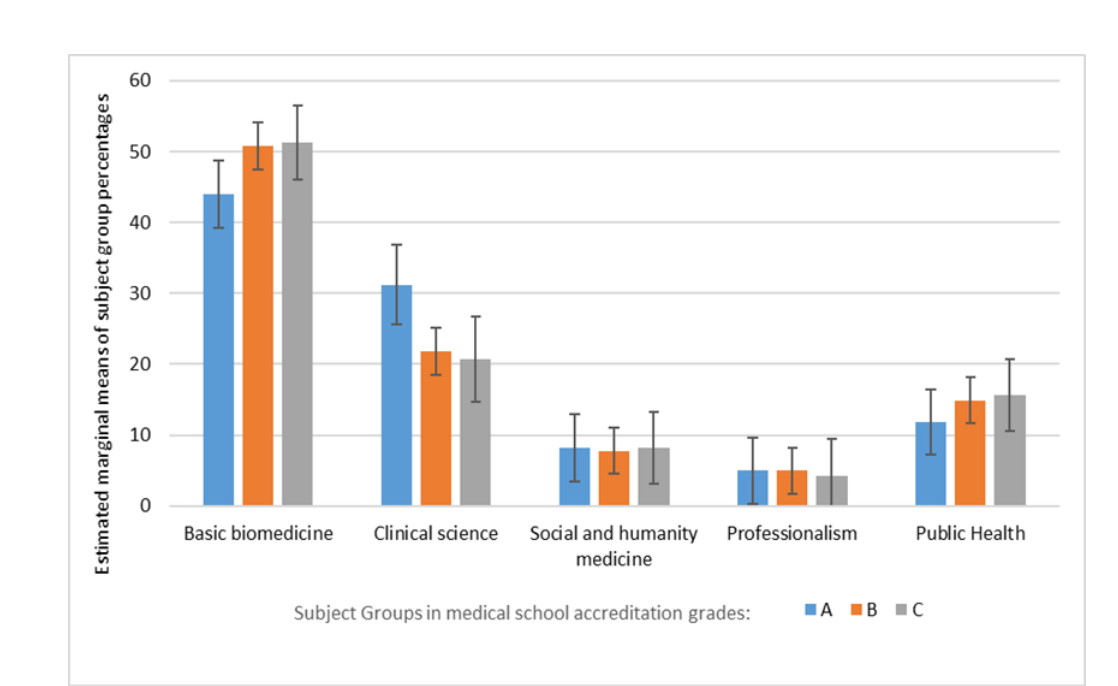
Figure 3. Estimated marginal means of subject grouping percentages in the bachelor phase of medical schools in Indonesia.